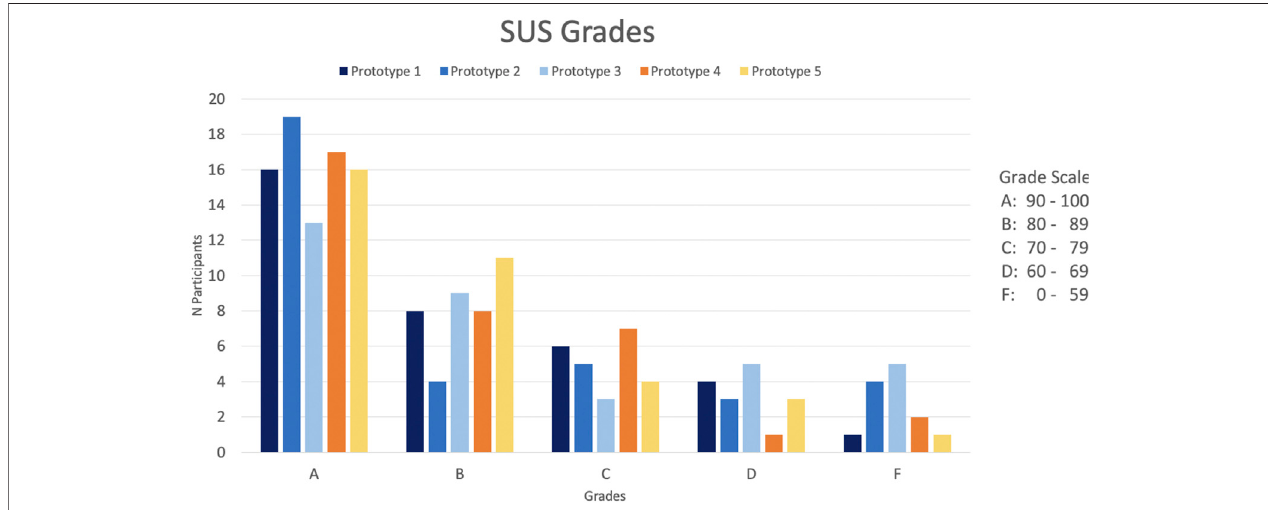
FIGURE 8 | Study 2: The SUS scores on the grade scale for each of the fi ve prototypes.